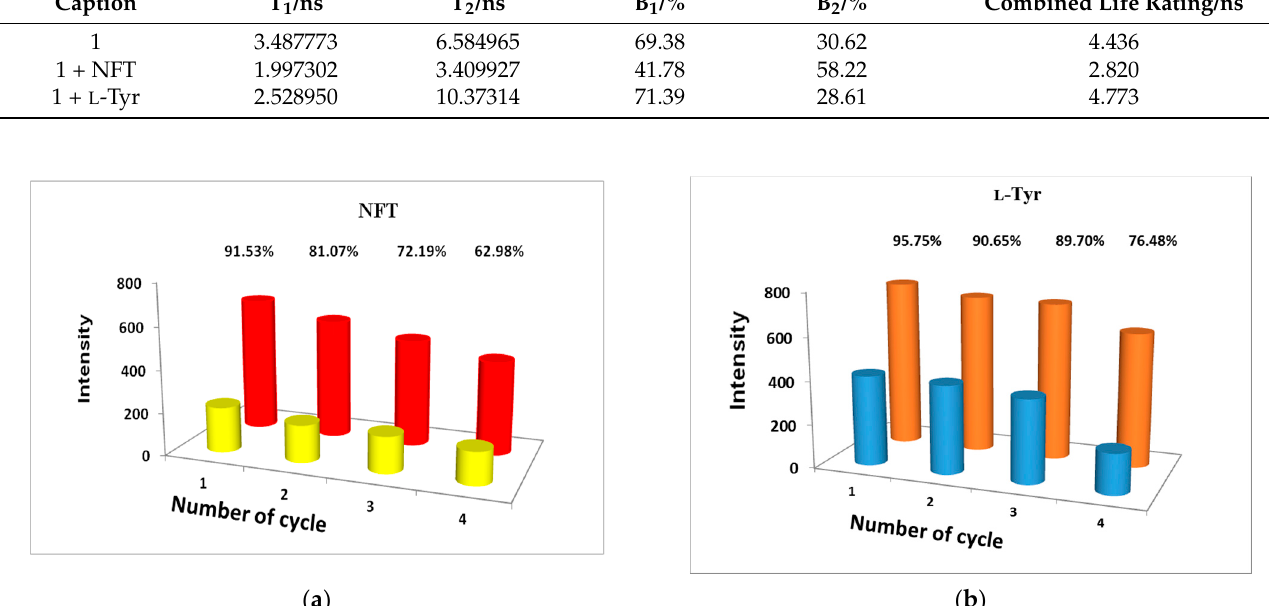
Figure 7. Cycling performance of luminescence intensities at 300 nm of 1 for detecting NFT ( a ) and L -Tyr ( b ).